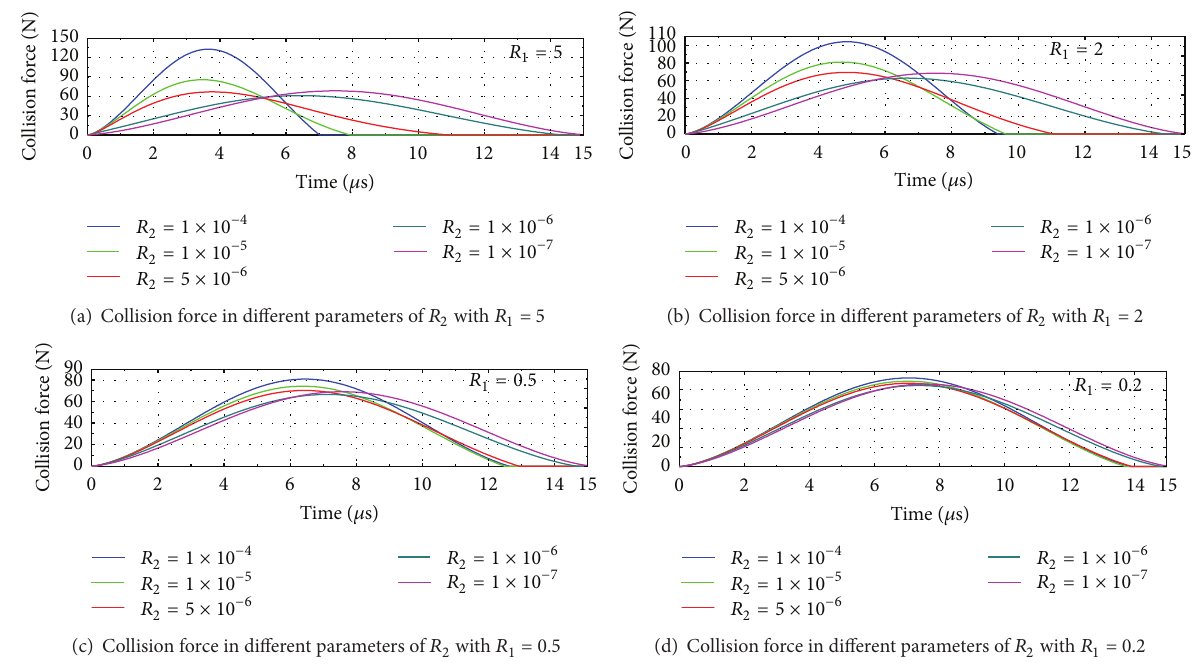
Figure 8: Collision force influenced by parameters of 𝑅 2 in different 𝑅 1 .